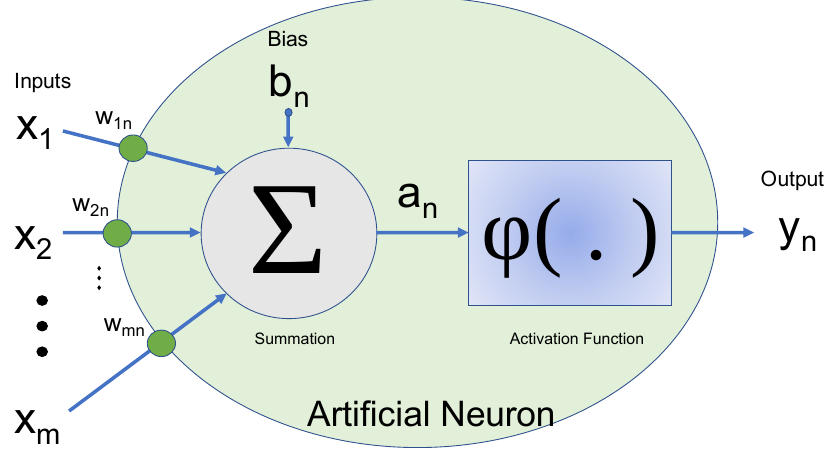
Figure 11. Artificial